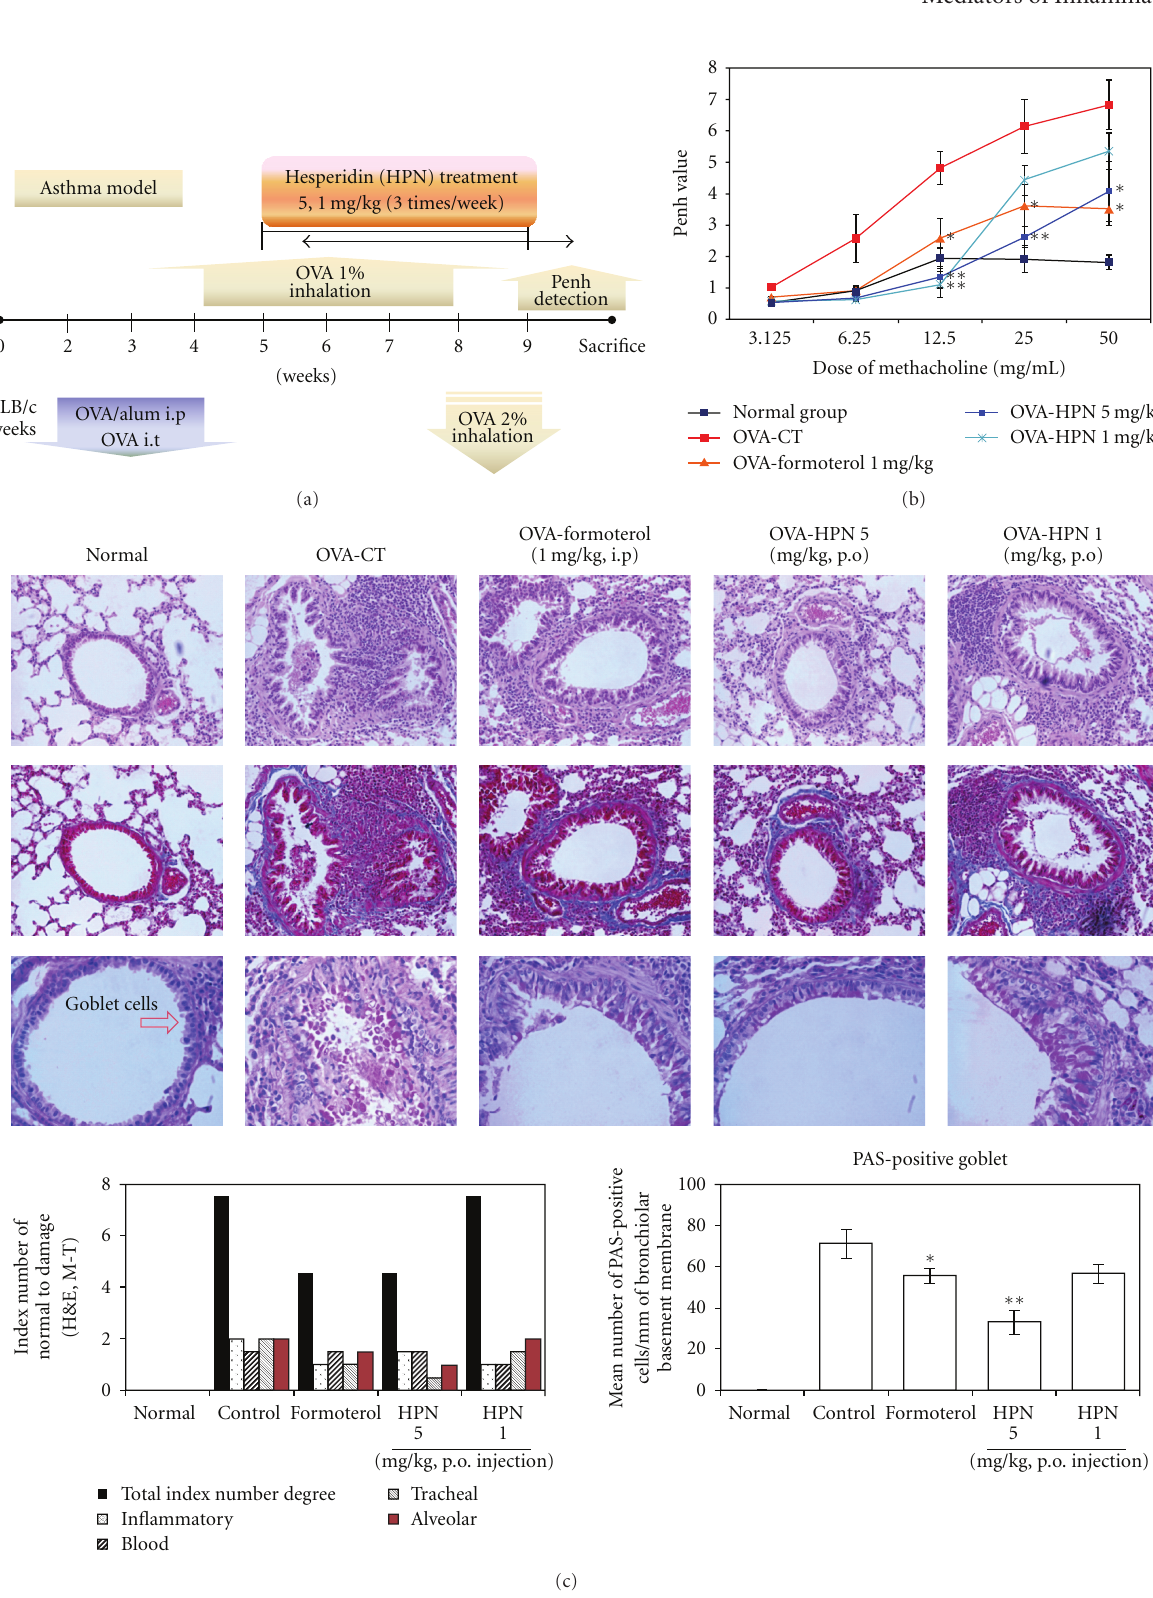
Figure 1: (a) Schematic diagram of methacholine-induced AHR in the sensitization protocol. (b) PenH was measured with a Buxco box, as described in Materials and Methods. ∗ P < . 05, ∗∗ P < . 01 for control goup versus HPN-treated groups (c), e ff ect of HPN on histology of lung tissue (H&E, M-T, and PAS staining) in lung cells of the OVA-induced murine model of asthma. H&E: hematoxylin-eosin stain, M-T: Masson trichrome stain, PAS: Periodic acid-Schi ff stain , N: normal BALB/c mice, CT (control): Ovalbumin inhalation + vehicle, OVA + formoterol (1mg/kg), OVA + HPN (5,